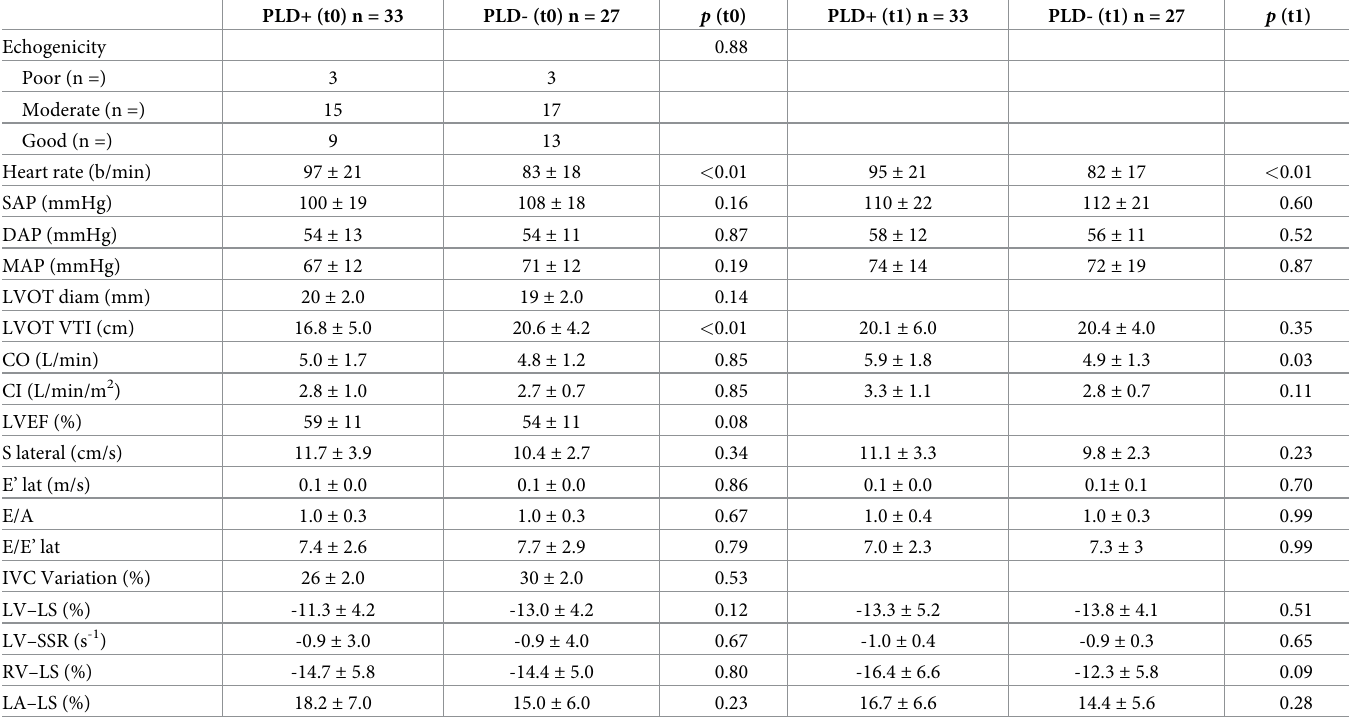
Table 2. Clinical and echocardiographic data before (T0) and during (T1) the passive leg raising maneuver.